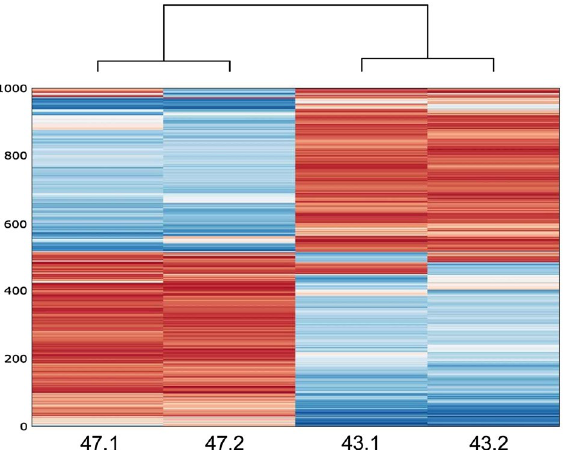
Figure 3. Cluster analysis of 1000 most variable CpGs. Clustered heatmap showing monocyte DNA methylation from two patients with PTSD (47 and 43), pre- (.1) and post-intervention (.2). CpG SNPs were excluded from the analysis. On the Y-axis, the 1,000 most variable CpGs are shown with DNA methylation levels ranging from blue (no methylation) to red (100%